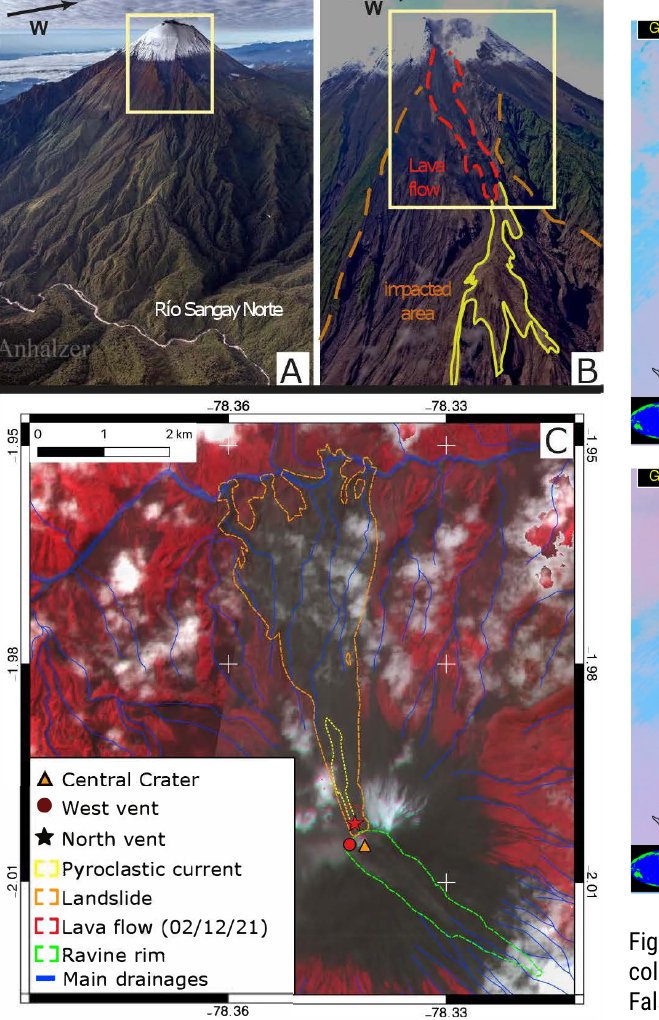
Figure 7: [A] Aerial photo of the northern flank of Sangay taken before November 2021. Photography courtesy of Jorge An- halzer; [B] Aerial photo of the northern flank of Sangay taken during an overflight on 27 December, 2021 (i.e., after the drum- beat sequence) by Benjamin Bernard; [C] Planet infrared image composition showing the new deposits and morphological fea- tures in the northern flank of Sangay volcano, including the two new vents.